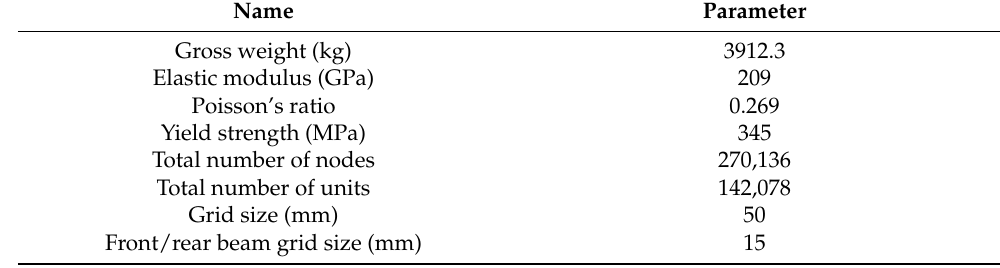
Contact site Max ： 280.18 MPa